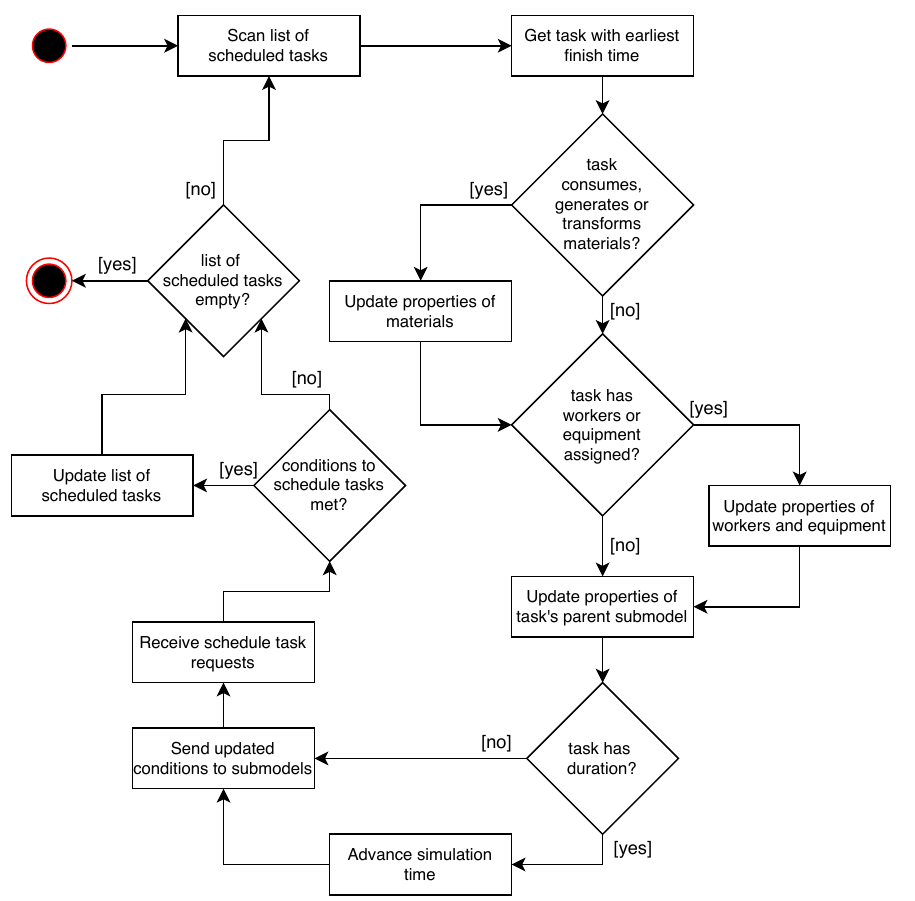
Figure 6. Time advancement flow